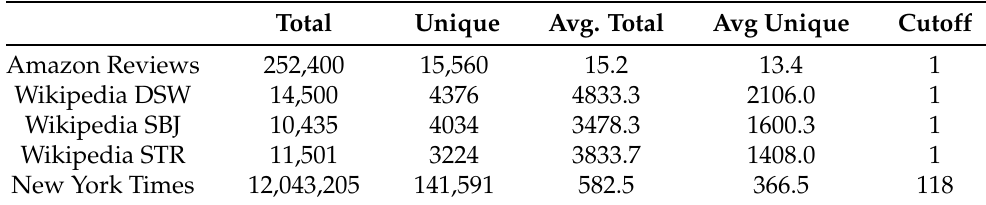
Table 4. Overview of word count statistics after preprocessing for all datasets. Columns represent from left to right the total number of words per corpus, total number of unique words per corpus, average number of total words per article, average number of unique words per article and the cutoff frequency of the 10,000th most common word. Wikipedia article combinations: Dolphin, Shark, Whale (DSW), Soccer, Bee, Johnny Depp (SBJ), Soccer, Tennis, Rugby